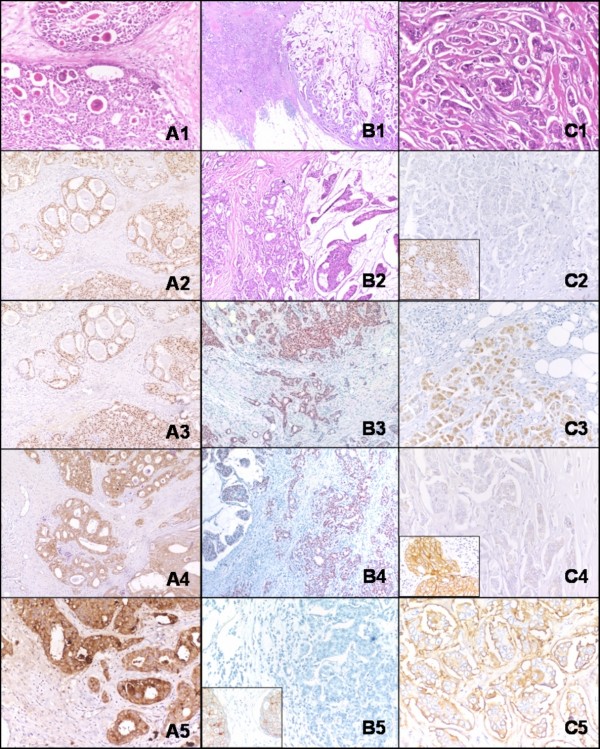
Invasive apocrine carcinoma with desmoplastic stroma (H&E, ×100). (A1), Estrogen receptor shows strong positivity (approximately %80 of the tumor cells) (A2), Progesteron receptor reveals the same features with ER (A3), Cytoplasm expression of HER2/neu, no membranous stainning (A4), Diffuse stainning for gross cystic disease fluid protein (GCDFP15) (A5), Invasive ductal component of the invasive mucinous carcinoma at the perifery of the tumor (H & E, ×40) (B1), H & E sections (×100) (B2), Approximately the whole of the tumor cells shows estrogen receptor positivity (B3), The same stainning features for progesteron (B4), There is no HER2/neu expression, whereas positive control reveals membranous staining (left corner) (B5), Tumor cells arranged in morula-like clusters, reffered to as an ''exfoliative appearance'' (H & E, ×100) (C1), There is no estrogen receptor positivity, whereas positive control reveals staining (left corner) (C2), Approximately 50% of the tumor cells show progesteron receptor positivity (moderate staining) (C3), There is no HER2/neu expression, whereas positive control reveals membranous staining (left corner) (C4), There is stainning for EMA (epithelial membran antigen) at the perifery (C5).